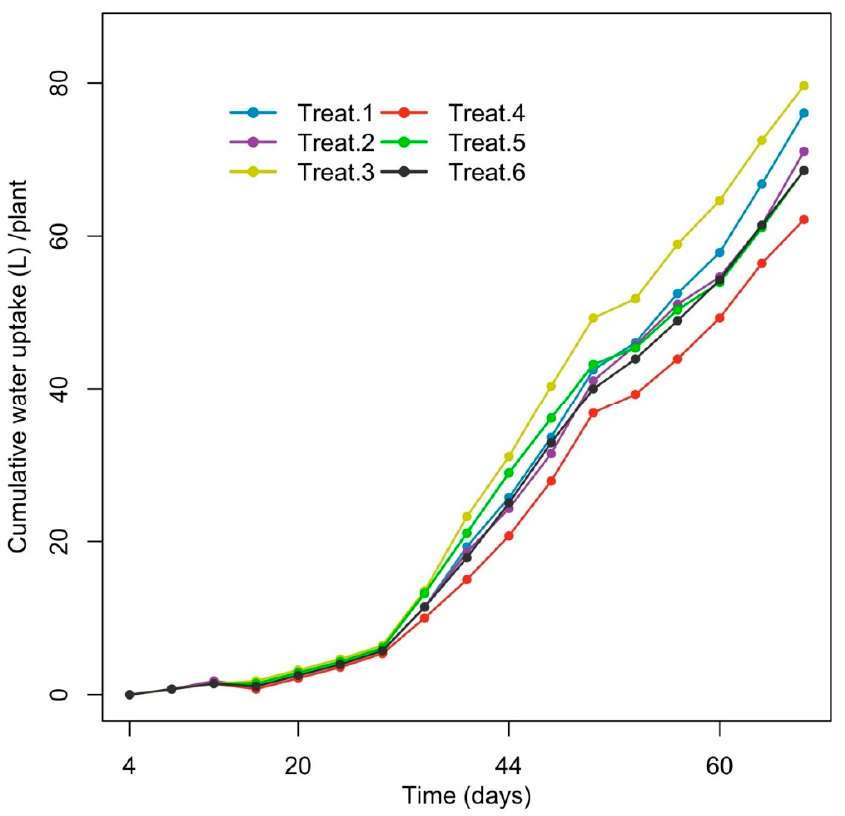
Figure 1. Cumulative water consumption per plant ( n = 14) over time in melons grown by closed hydroponic system treated with different nutrient concentrations.